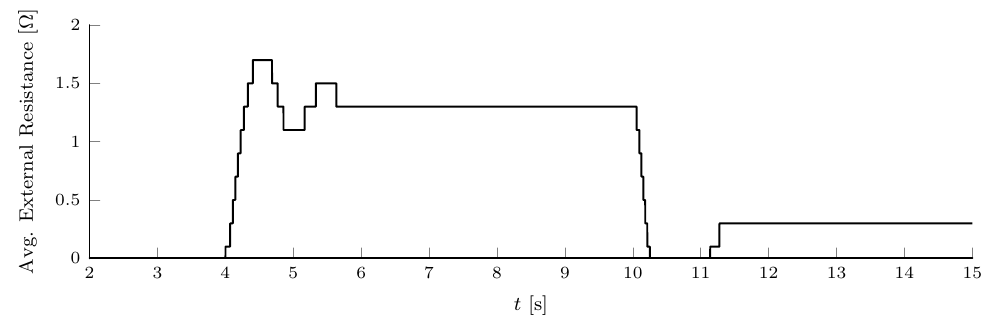
Figure 29. External stator resistance of secondary motor: torque sufficiency study.